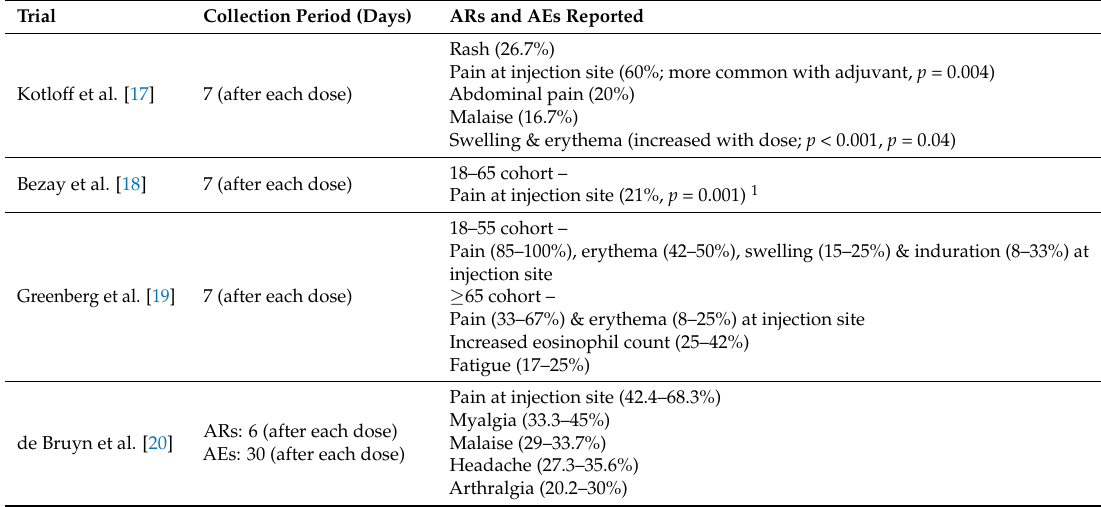
Table 1. Safety outcomes most commonly reported by